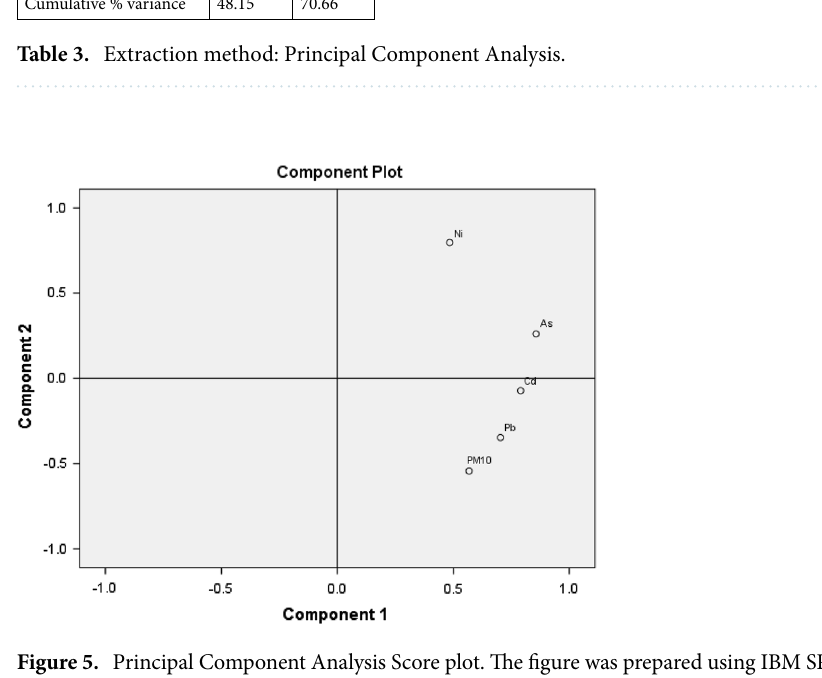
Figure 5. Principal Component Analysis Score plot. The figure was prepared using IBM SPSS statistics 22.